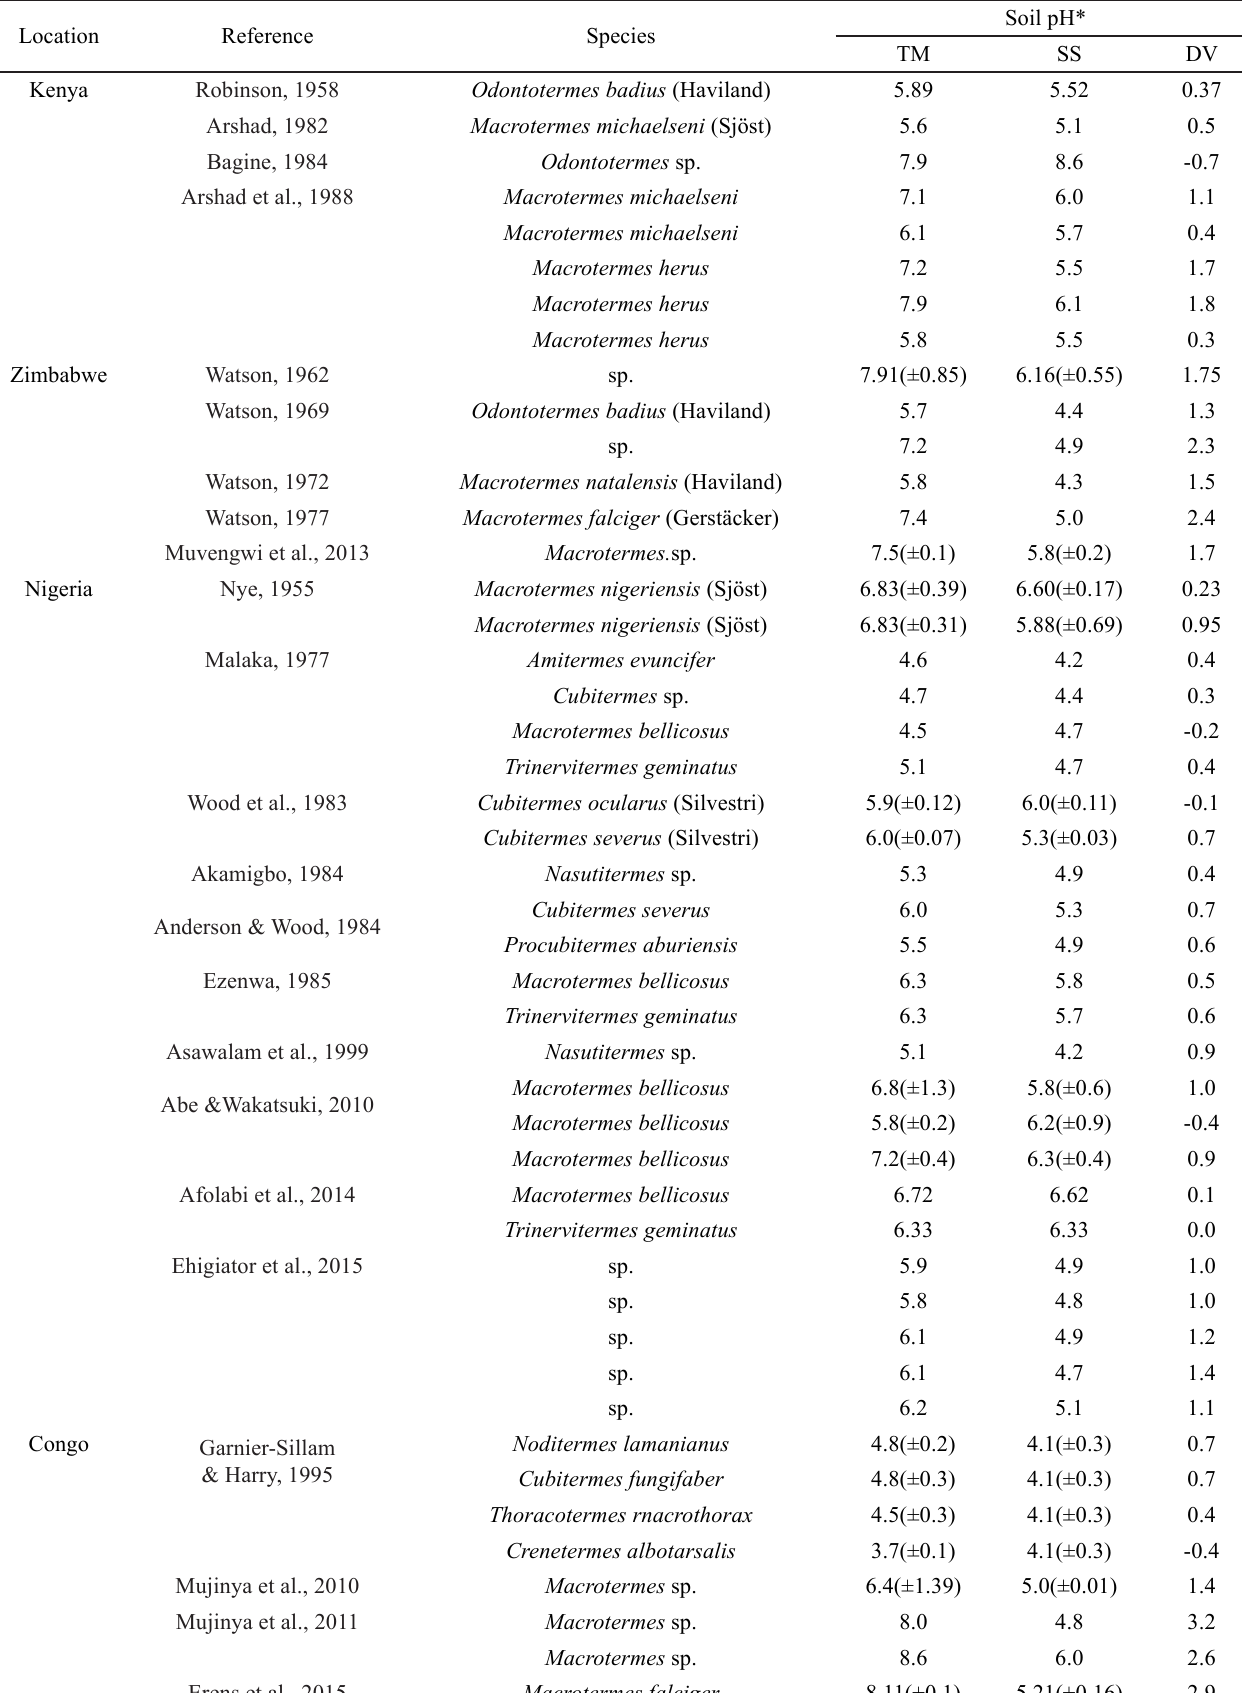
Table 3. Summary for the pHs of termite mounds (TM) and surrounding soils (SS) from